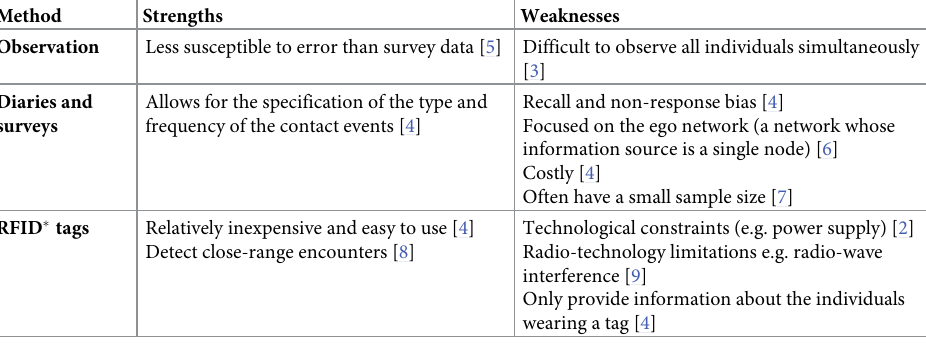
Table 1. Summary of strengths and weaknesses of selected contact pattern collection